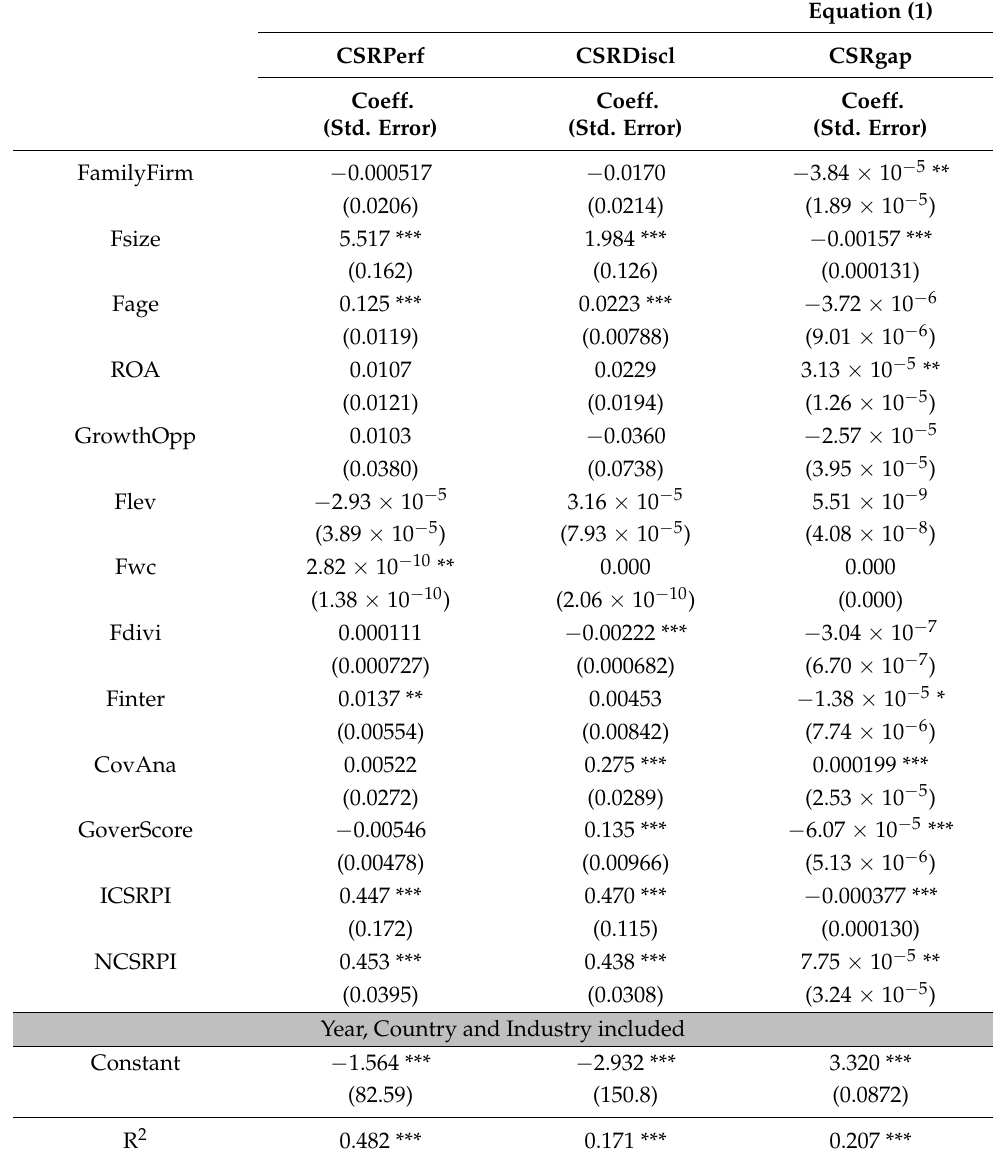
Table 4. Dependence models (*** p < 0.01, ** p < 0.05, * p <